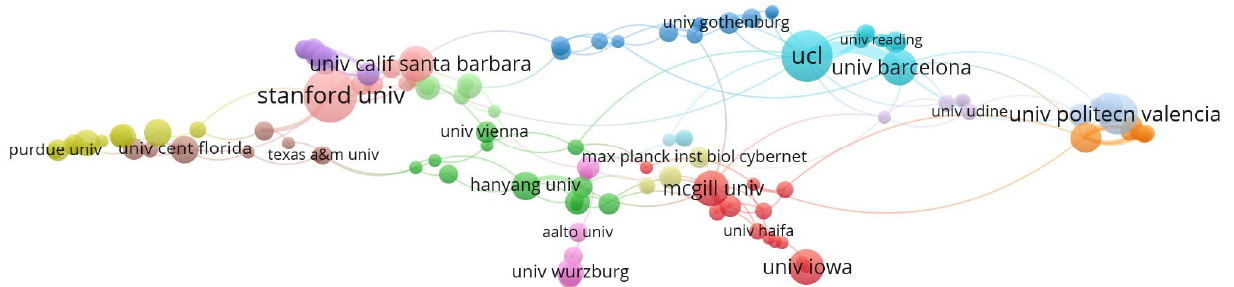
Figure 8. Map of affiliation collaboration networks.